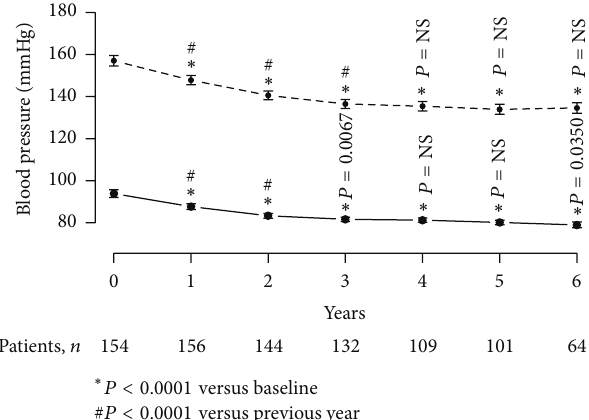
Figure 8: Systolic (dotted line) and diastolic (continuous line) blood pressure (mmHg) in 156 obese hypogonadal men with type 2 diabetes treated with testosterone undecanoate injections for up to 6